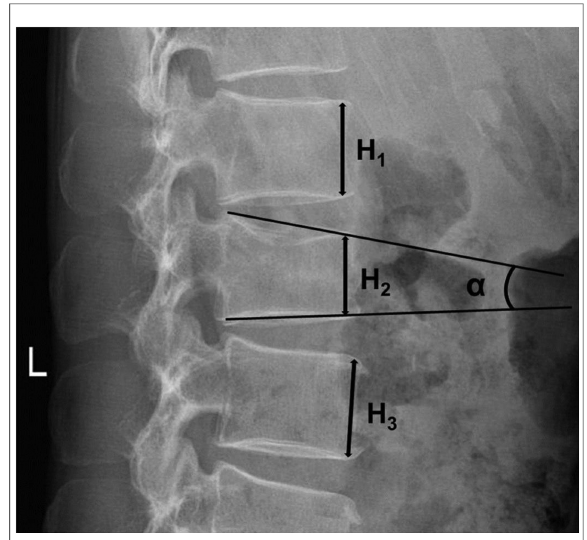
FIGURE 1 Schematic diagram of radiological parameters measurement of the four groups. H 1 : the anterior height of the vertebrae above the injured level; H 2 : the anterior height of the injured vertebrae; H 3 : the anterior height of the vertebrae below the injured level. AVH (%)=2H 2 /(H 1 +H 3 ); VWA(°): α , the angle between the superior endplate and inferior endplate of the injured